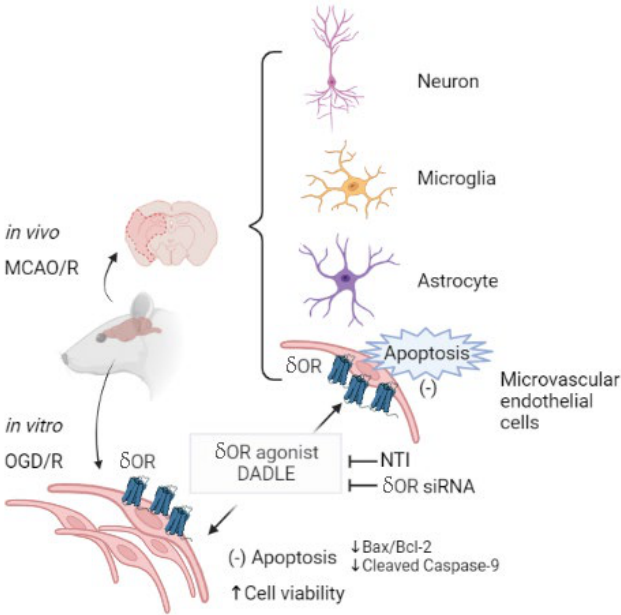
Figure 6. Schematic representation shows that delta opioid peptide DADLE targets BMECs reducing apoptosis to relieve hypoxia-ischemic/reperfusion injury. Pre-treatment with the δ OR agonist DADLE can reduce cerebral vascular endothelial apoptosis and then relieve tissue injury induced by MCAO/R. In vitro, δ ORs’ expression is detected on the primarily cultured BMECs. DADLE can reduce the apoptosis of BMECs, and then increase their viability. Both δ OR antagonist NTI and interference of δ OR can abolish this effect. Specifically, DADLE can reduce the cleaved caspase-9 and decrease the ratio of the protein level of Bax and Bcl-2.